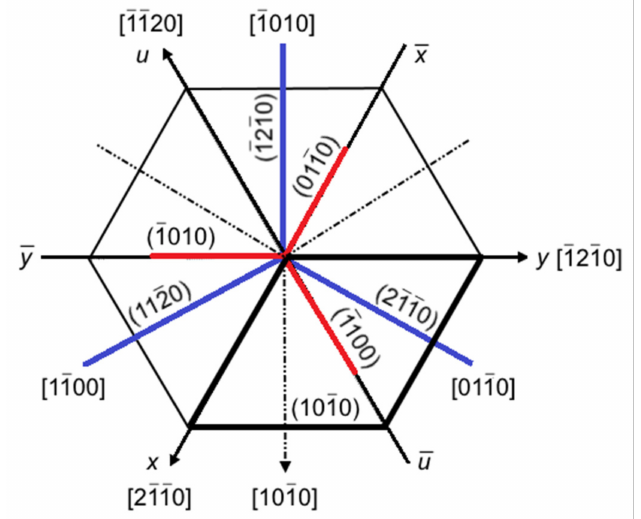
Figure 1. Crystallographic directions and planes for the CeF 3 in a hexagonal setting. The black bold line represents the (0001) unit cell projection ( a = x , b = y and c = z